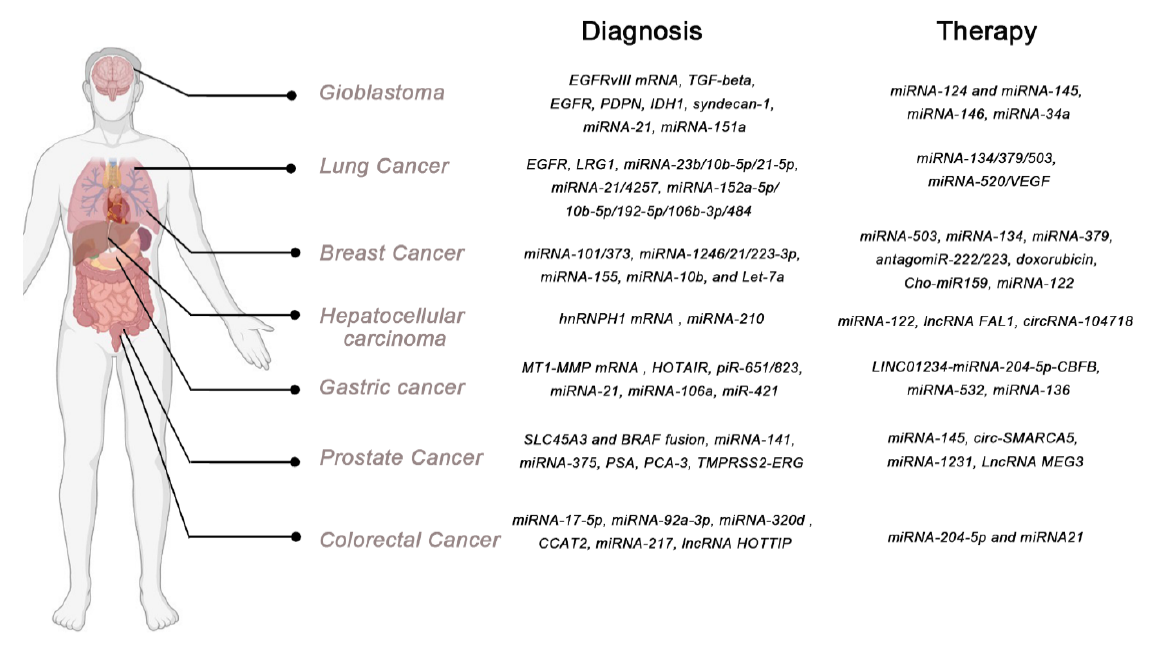
Figure 3. Exosome-associated molecules used for diagnosis and therapy. For instance, epidermal growth factor receptor variant type III (EGFRvIII) is associated with the classical glioblastoma (GBM) subtype [345]. MicroRNA (miRNA)-124 has been reported to enhance the chemosensitivity of GBM cells to temozolomide and to decrease GBM cell migration [346]. In addition, the delivery of miRNA-34a results in the inhibition of GBM cell proliferation, invasion, migration and tumurogenesis both in vivo and in vitro [347]. Lung cancer was also detected using exosomal biomarkers. In this context, Liu et al. found that miRNA-23b/10b-5p/21-5p were good candidates for its diagnosis [348], while Dejima and coworkers considered miRNA-21/4257/451a reliable biomarkers [349,350]. Other miRNAs such as homo sapiens (hsa)-miRNA- 320d/320c/320b were suggested as potential biomarkers [351]. On the other hand, exosome miRNA-101/373 serum levels were found to be linked to aggressive breast carcinomas [352]. Other authors recommend miRNA-1246/21/223-3p as potential indicators of breast cancer [353,354]. Therapeutic quantities of doxorubicin (Dox) and cholesterol-modified miRNA 159 (Cho-miRNA-159) were delivered to triple-negative breast cancer (TNBC) cells and exhibited improved anticancer effects [355]. In addition, miRNA-204-5p and miRNA-21 efficiently inhibited cancer cell proliferation and increased chemosensitivity by specifically suppressing their target genes in human colorectal cancer cells [356,357]. Adipose-derived stromal cells (ASCs) were shown to be able to promote prostate cancer cell apoptosis via exosomal miRNA-145 through the caspase-3/7 pathway [358,359].